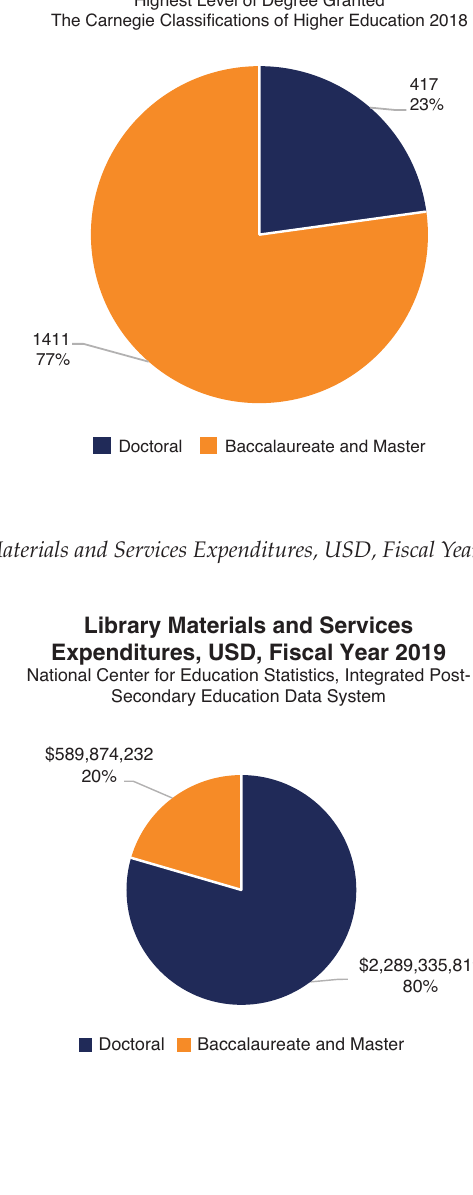
Chart 1: U.S. Four-Year and Graduate Institutions: Highest Level of Degree